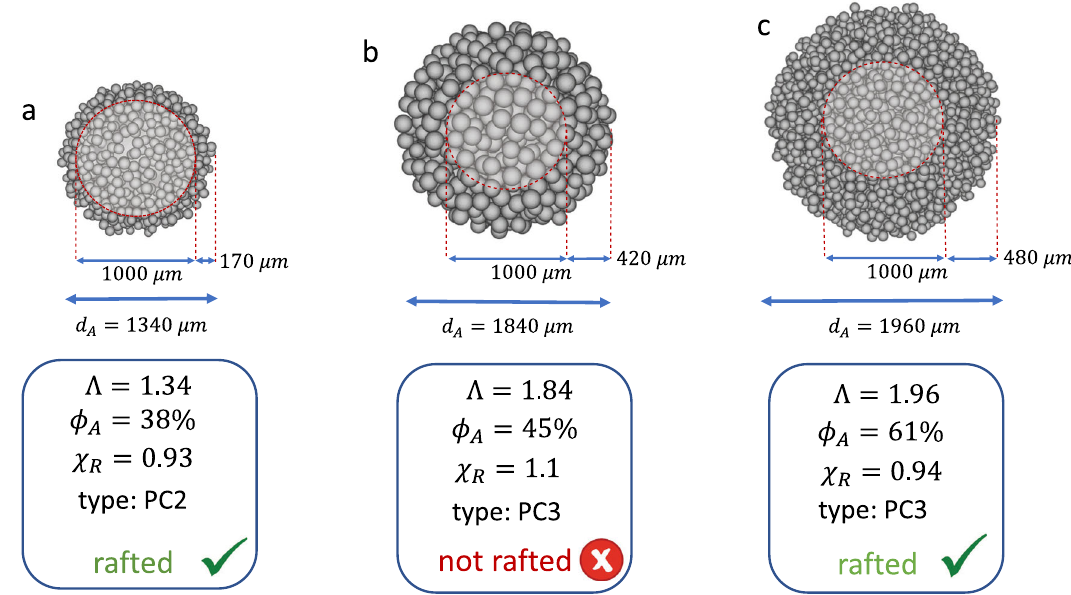
Fig. 4 Examples of rafted and not rafted aggregates. PC2 and PC3 aggregates associated with a core of 1000 μ m, generated with SCARLET-1.0 22 , a dedicated software for virtual reconstruction of aggregates. Aggregate type (e.g., PC2 or PC3) is de fi ned according to the combinations of ϕ A and Λ reported in Fig. 3 and in the literature 18 . In detail: a PC2 aggregate with a coating made of 1000 particles of sizes between 70 μ m and 90 μ m; the resulting porosity ϕ A and aggregate-to-core size ratio Λ generate a delayed sedimentation of the core ( χ R < 1). b PC3 aggregate with a coating made of 1000 particles between 120 μ m and 150 μ m that generate a premature sedimentation of the core ( χ R > 1). c PC3 aggregate with a coating made of 4000 particles of sizes between 70 μ m and 90 μ m that result in a delayed sedimentation of the core ( χ R < ≈ 200 μ m. As an example, by means of a dedicated software 22 , we between 70 – 90 μ m in size that are arranged to give a bulk porosity ϕ A = 38% and an aggregate-to-core ratio Λ = 1.34 simulated three aggregates that, according to their combinations of ϕ A and Λ (see Fig. 3), are classi fi ed respectively as a PC2 (Fig. 4a). This con fi guration is already suf fi cient to produce a (Fig. 4a) and PC3 aggregates (Fig. 4b, c), but with different porosities. In all of these cases the core has a size d P = 1000 μ m. In the PC2 case, the coating is composed of 1000 particles